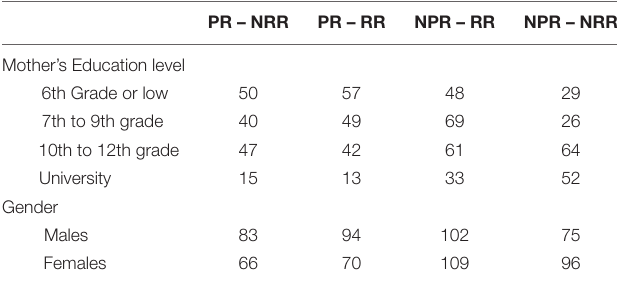
TABLE 1 | Student distribution by retention status, mother’s education level and